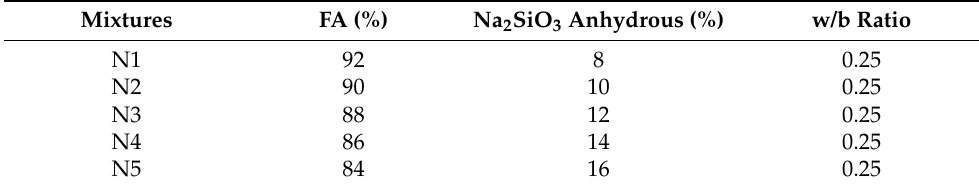
Table 2. Mix proportion of one-part alkali-activated